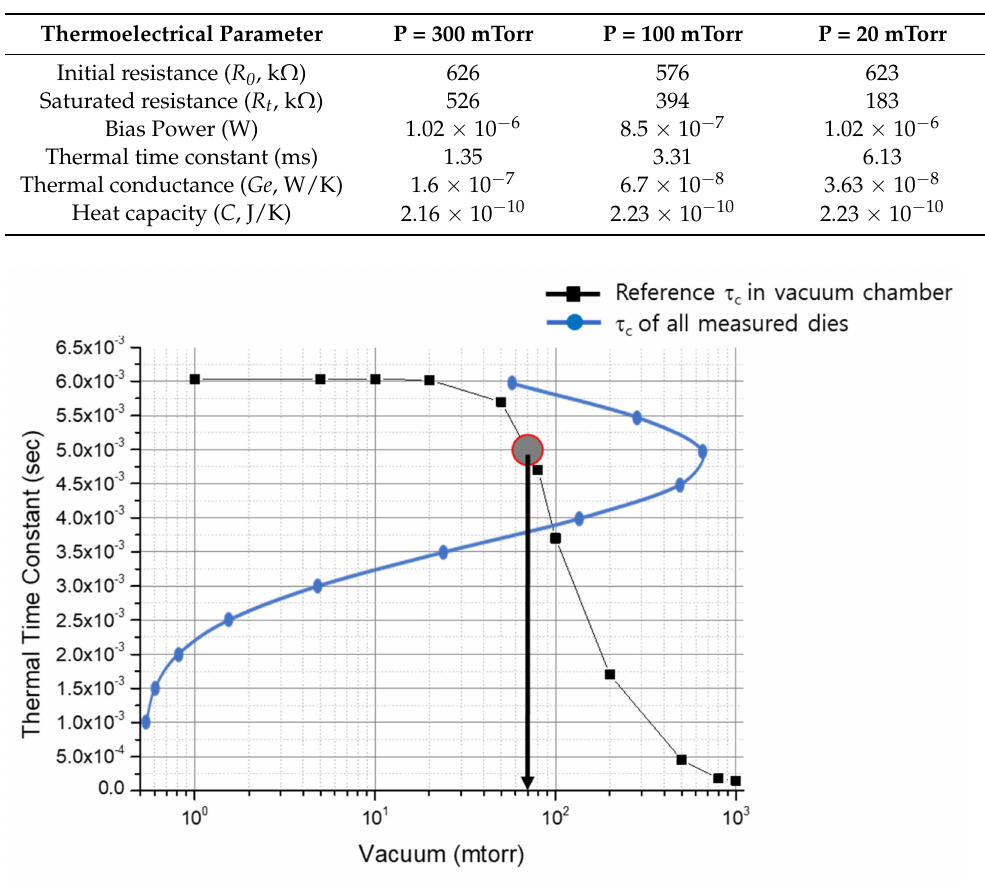
Table 1. Calculation of thermoelectrical parameters from the thermo-resistance curve (Figure 10) based on vacuum pressure.